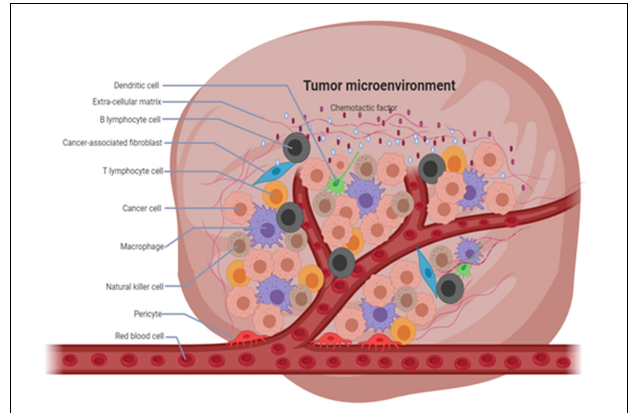
FIGURE 1 | Composition of tumor microenvironment (TME). TME has a complex composition, consisting of immune cells, fibroblasts, and other components which play an important role in the development of cancer.